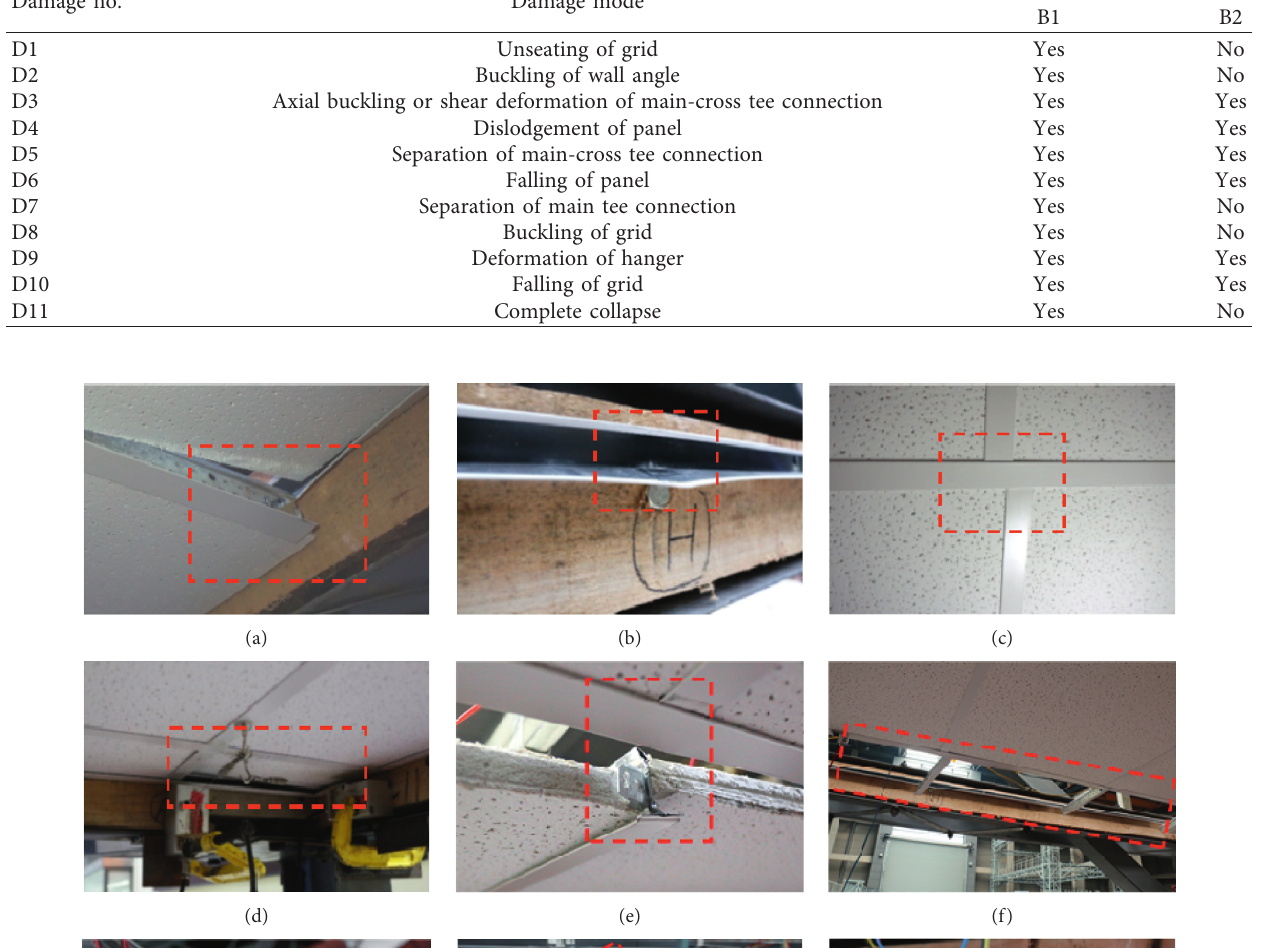
Table 2: Damage modes of the specimen during the shaking table tests. Damage no.